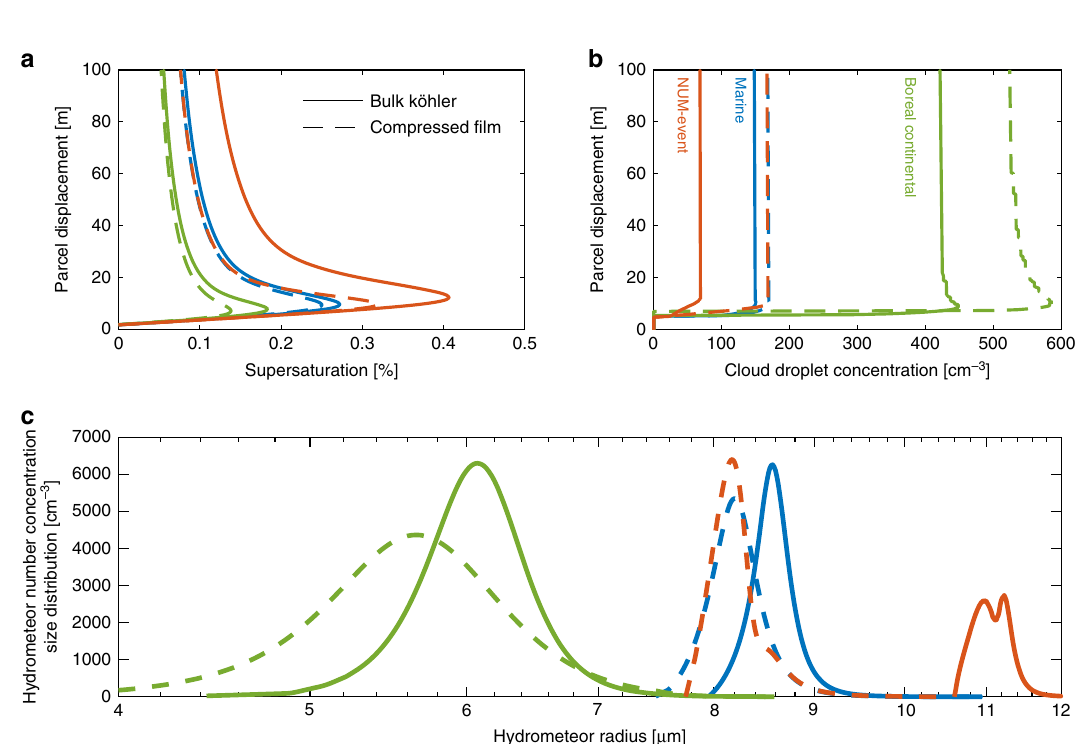
Fig. 2 Simulated microphysics of cloud events on marine (MA, blue), boreal (HYY, green) and NUM-event (NE, orange) aerosol populations. Cloud- formation event simulations using bulk Köhler BK (solid lines) and approximate compressed fi lm CF (dotted lines) models of cloud droplet activation with initial temperature T = 280 K, pressure P = 98,000 Pa, supersaturation s = − 0.1% and fi xed updraft velocity w = 0.32 ms − 1 . Simulated ( a ) ambient parcel supersaturation and ( b ) cloud droplet number concentration during parcel ascent. c Simulated droplet size distribution at a parcel displacement 200 m above